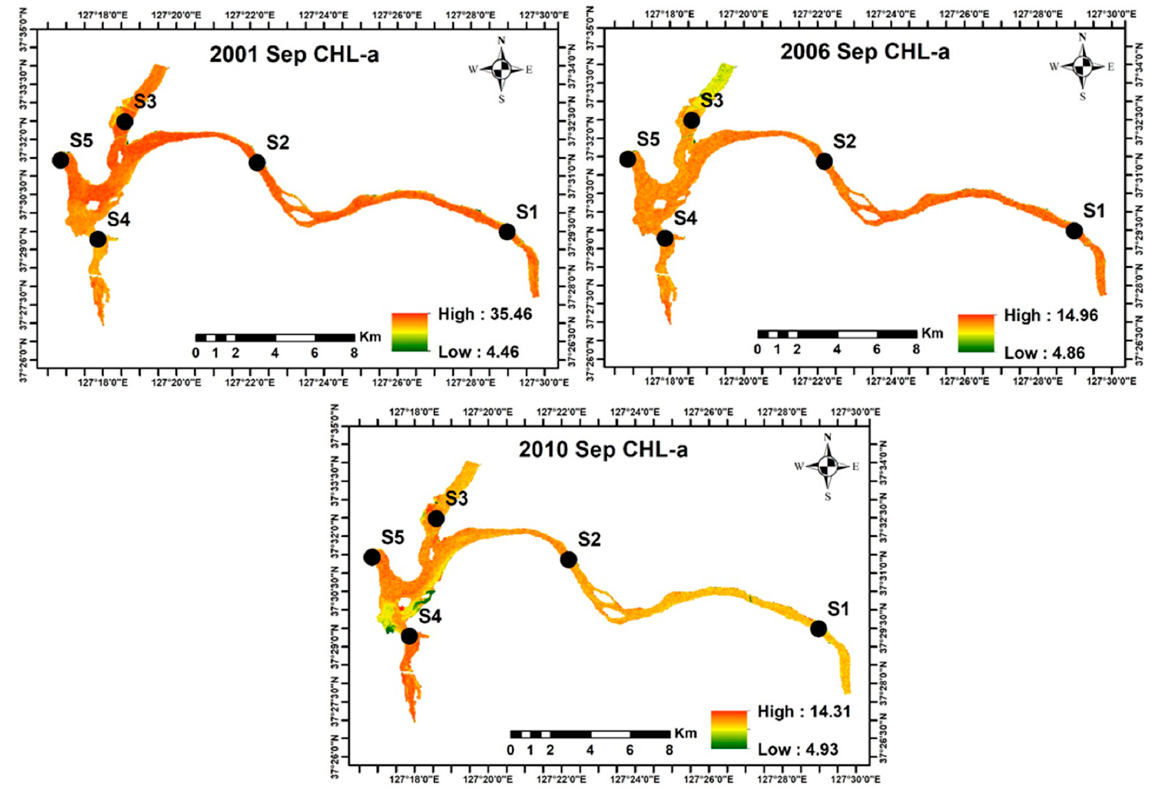
Figure 6. Spatial and temporal pattern of chlorophyll-a (CHL-a) on September 2001, 2006 and 2010.